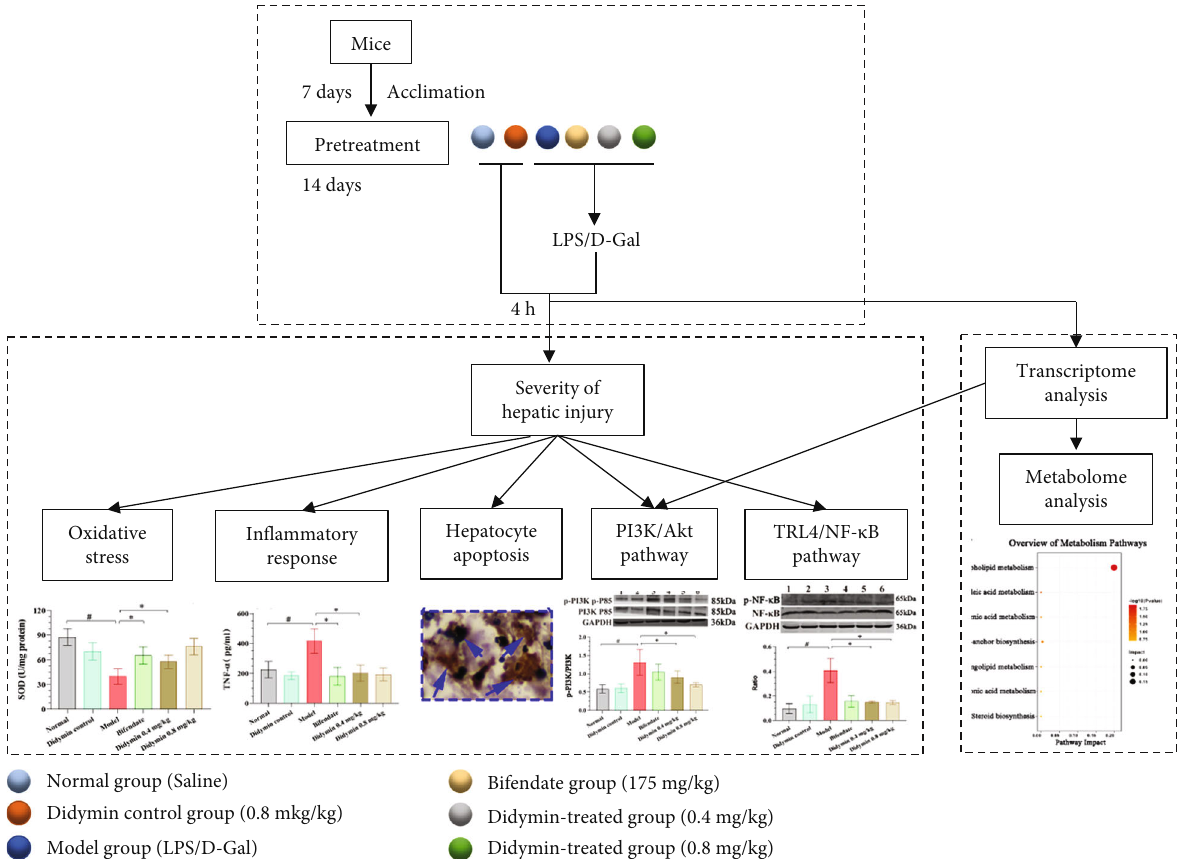
Figure 1: Design of this research. (a) The schedule of raising mice. (b) Animal experiments were conducted. (c) Transcriptomics and metabolomics